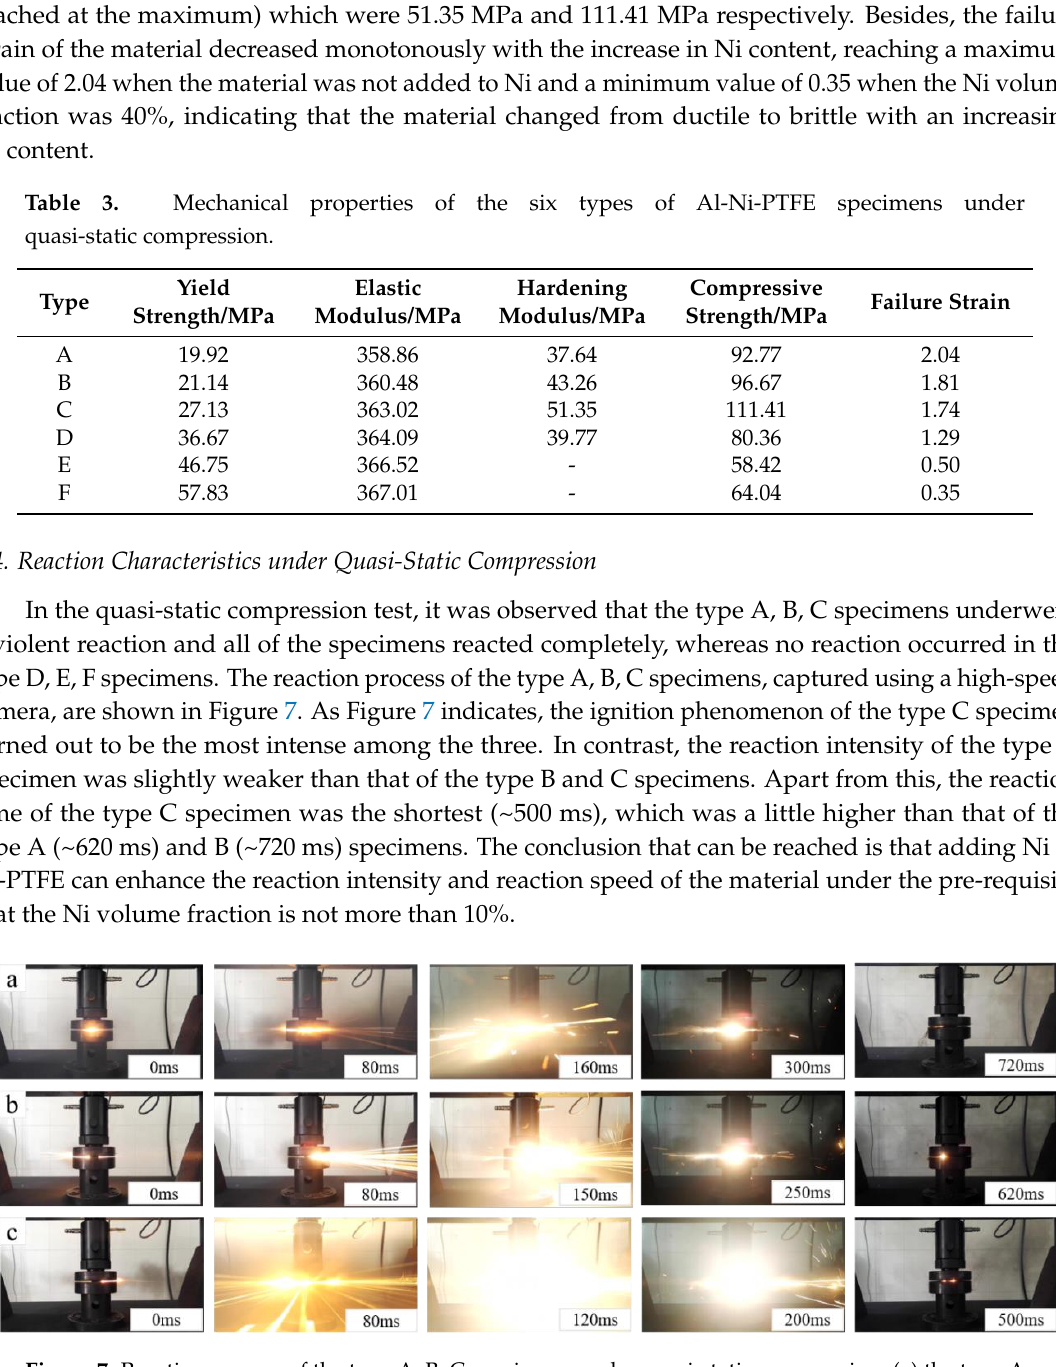
Figure 7. Reaction process of the type A, B, C specimens under quasi-static compression: ( a ) the type A specimen; ( b ) the type B specimen; ( c ) the type C specimen.